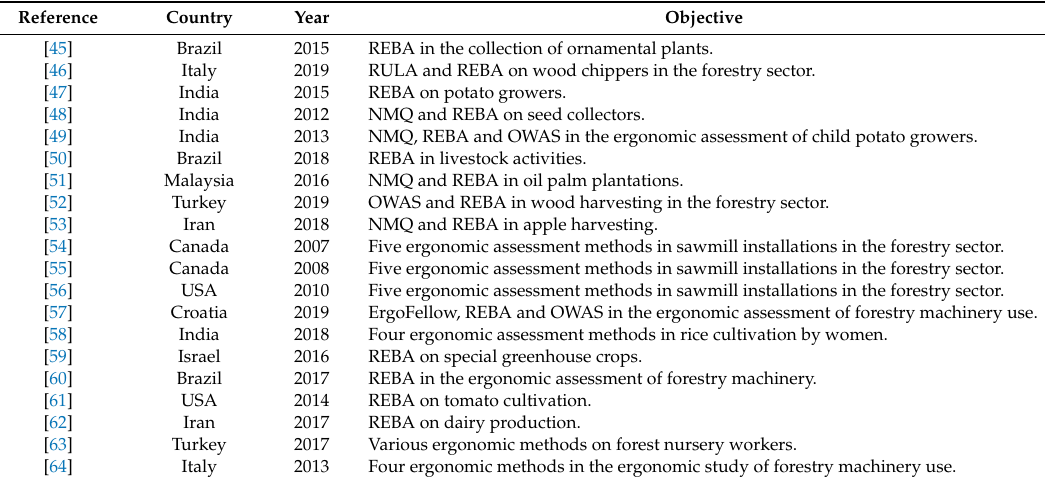
Table 4. Agriculture, forestry and